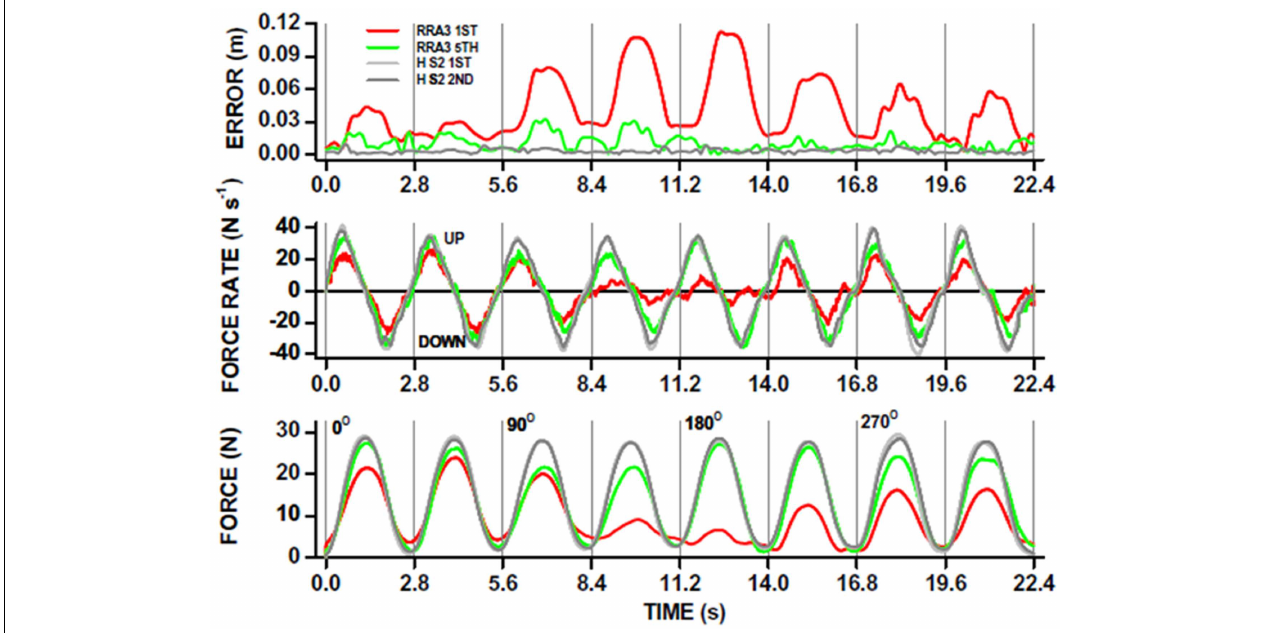
traces; RRA3 first) and after (green traces; RRA3 fifth) the robot-assisted therapy program.The overall x - y position error (top panel) was significantly reduced after robot-assisted therapy toward that measured in healthy subjects (gray traces; HS2 first and second). Note that position holding performance was direction-specific in this patient.The kinematic improvement in position holding was the result of increases in kinetic force production (bottom panel) and also the rate of force production (UP) and relaxation (DOWN; middle panel) toward that of healthy subjects. From Ref. (117) with